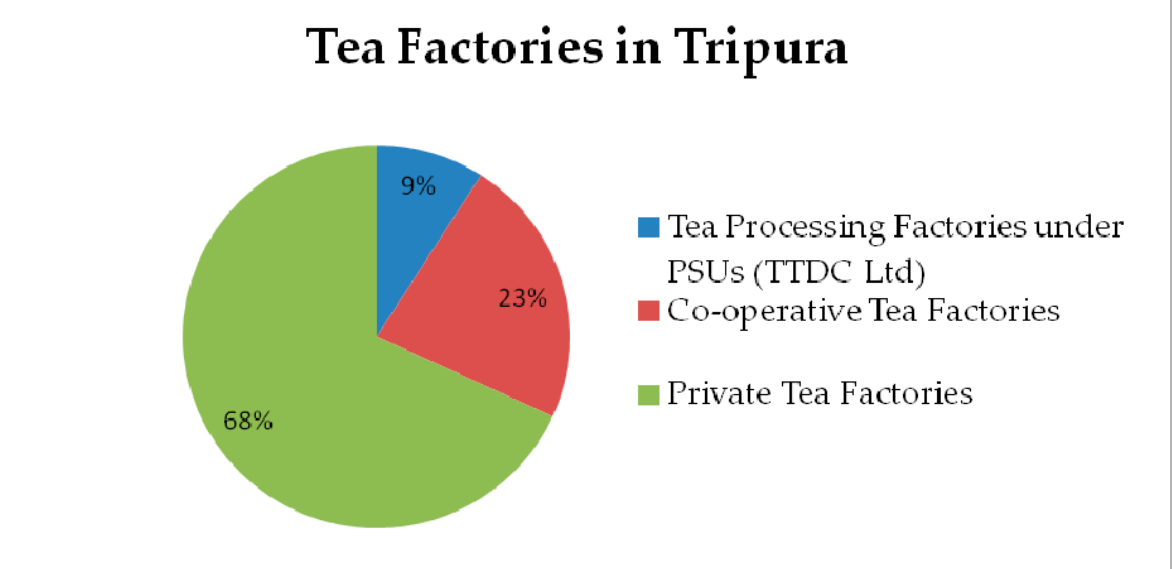
Table 2. Position of functioning Tea Factories. Sl.No.